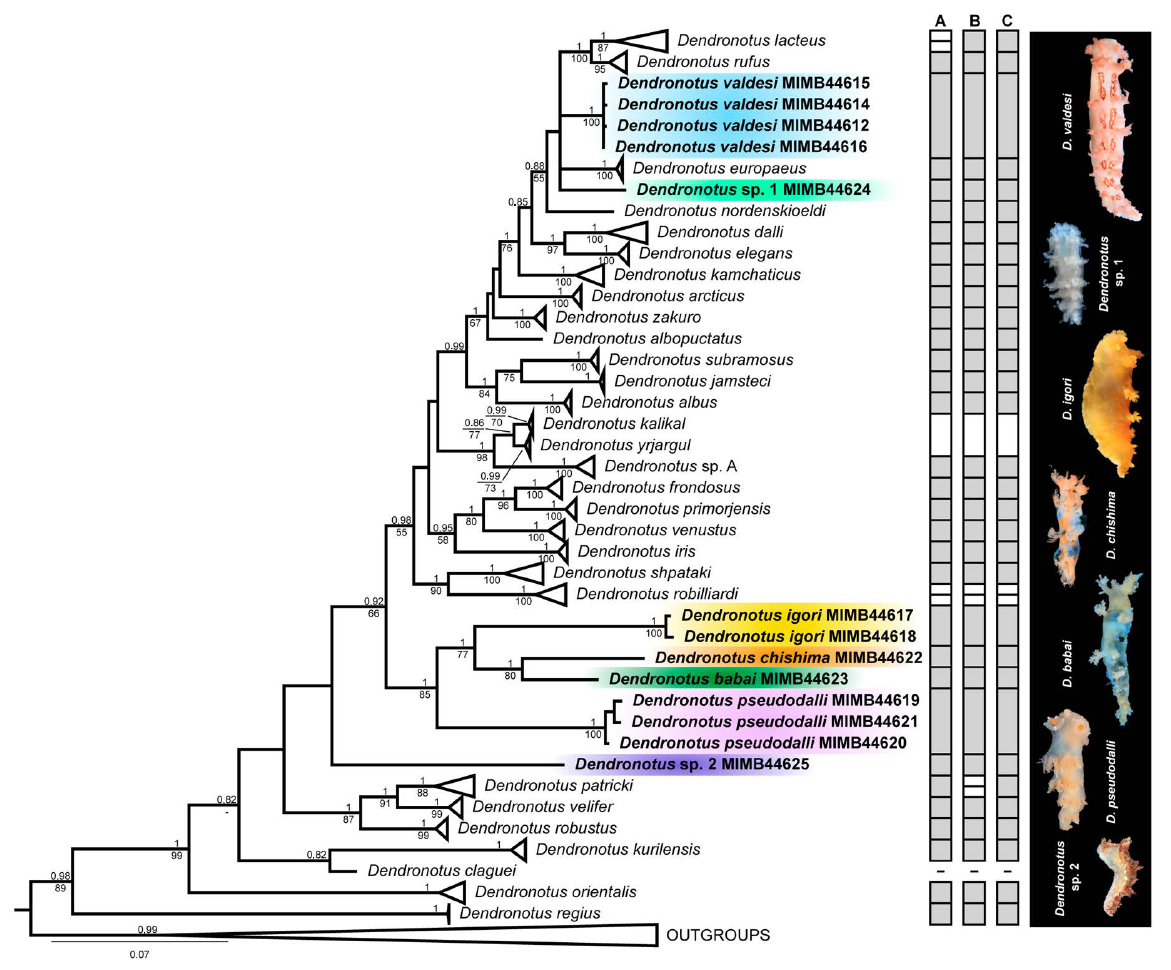
Figure 10. Molecular phylogenetic hypothesis recovered by Bayesian Inference based on the con‑ catenated dataset of four markers (COI + 16S + H3 + 28S); species‑level clades and outgroups are collapsed to a single branch, except for target species. Numbers above branches indicate posterior probabilities from Bayesian Inference (>0.85), while numbers below branches—bootstrap support from Maximum Likelihood (>50). Summary of species delimitation results is given on the right: A— ASAP; B—GMYC; C—bPTP; white boxes indicate incongruences with initial species hypothesis. Box with photos illustrates the external morphology of putative new